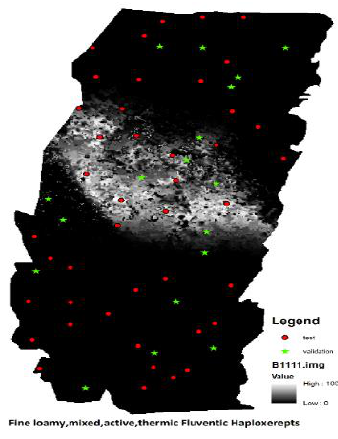
Figure 3. Predicted fuzzy soil family of B1111